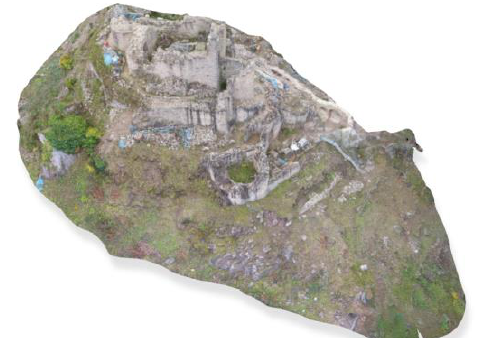
Figure 1: 3D model as textured mesh model of the Kagenfels’ remains in its current stage (end 2017), on about 80 m x 60 m.